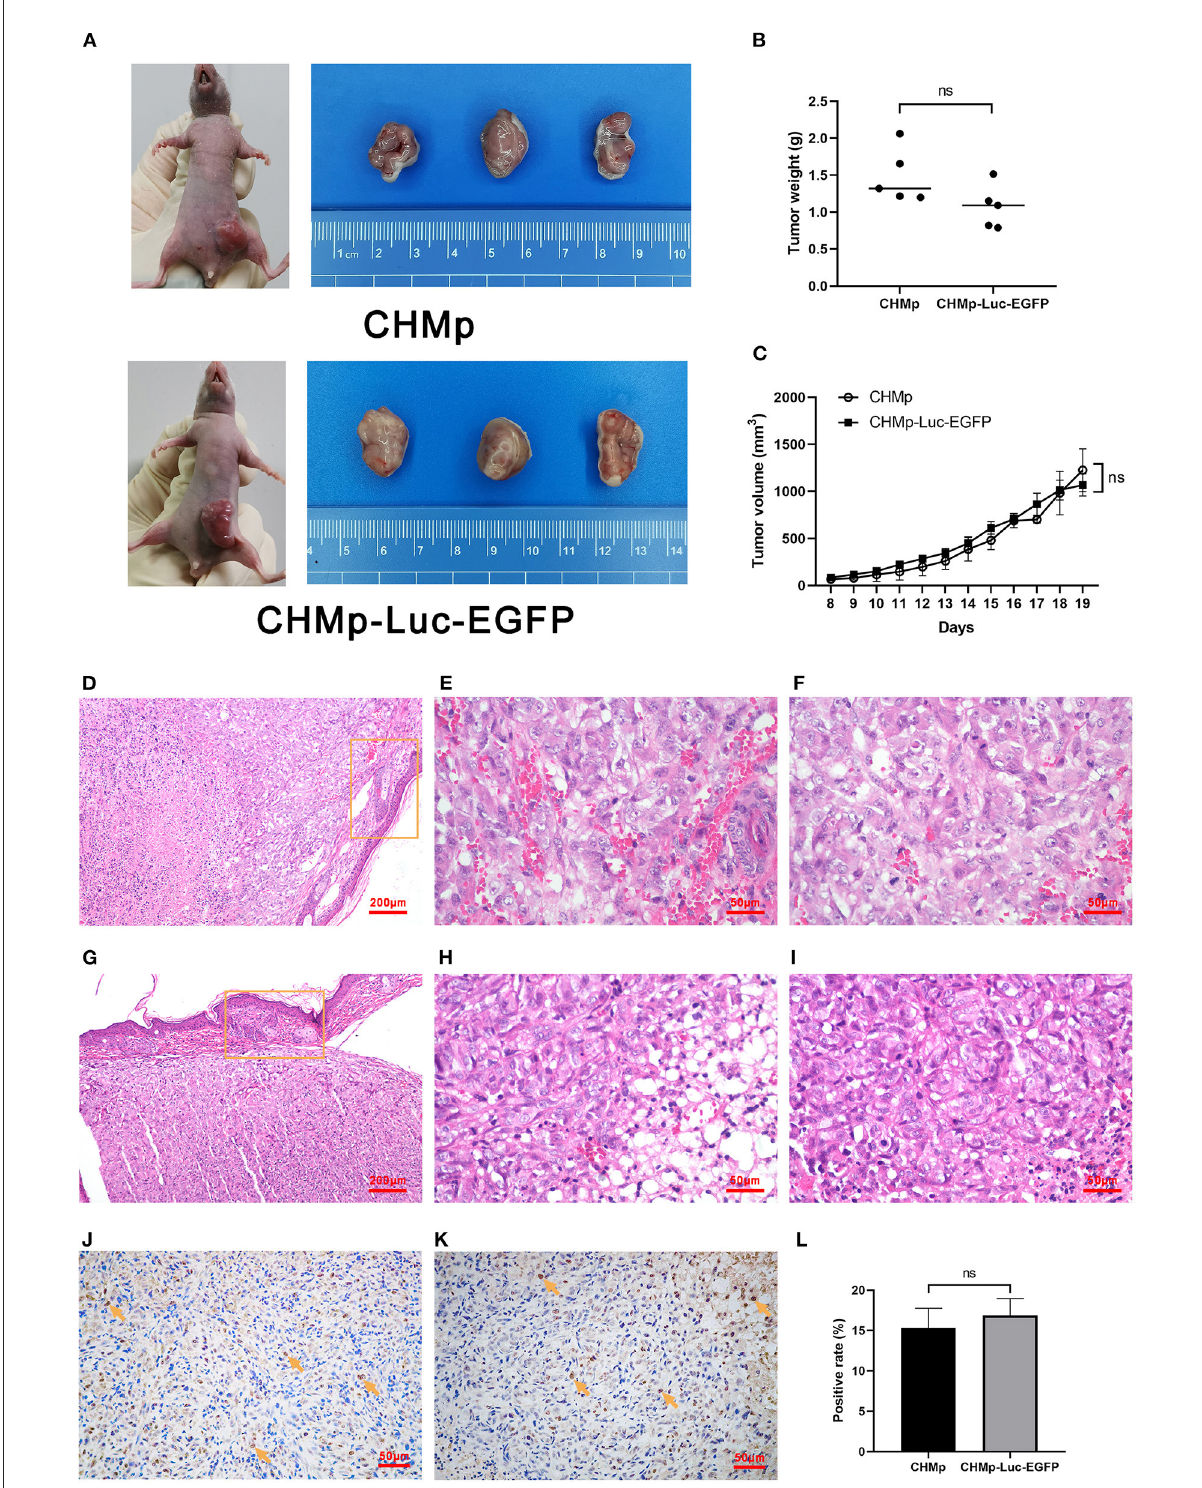
FIGURE4 Tumorigenicity assay and histological sections of tumors derived from CHMp and CHMp-Luc-EGFP. (A) The volume of subcutaneously transplanted tumors. (B) Weight of subcutaneously transplanted tumors. Significance was determined using a two-tailed unpaired t -test; ns, non-significant. n = 5. (C) Changing sizes of subcutaneously transplanted tumors in each group over time. Significance was determined using